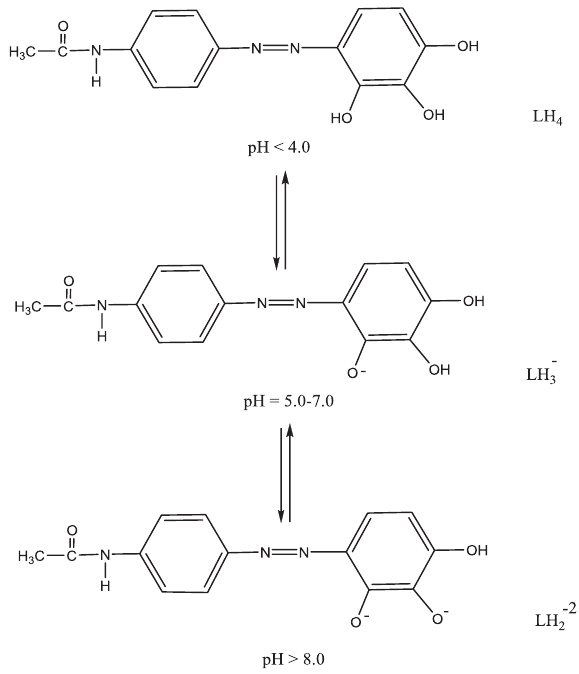
Figure 14: Ionization forms of 4-APAP in acidic, neutral, and basic media.